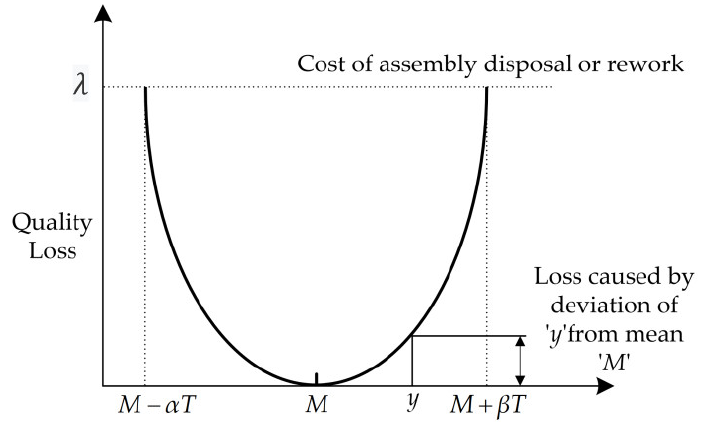
Figure 3. Functional image of the nominal-the-best Taguchi quality loss model.